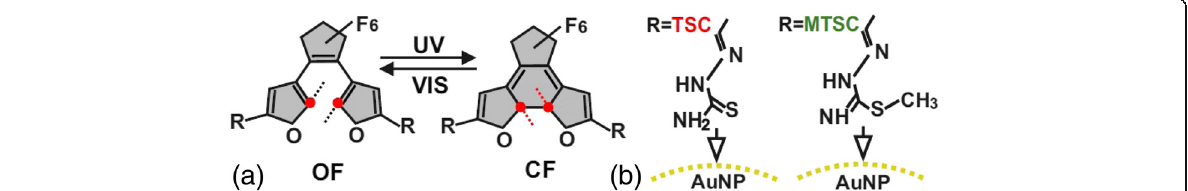
Fig. 1 a The schematic representation of photoinduced switching between open-ring (OF) and closed-ring (CF) forms of DAEs under ultraviolet (UV) and visible (VIS) light illumination. b The structures of TSC ( left ) and MTSC ( right ) side-chain